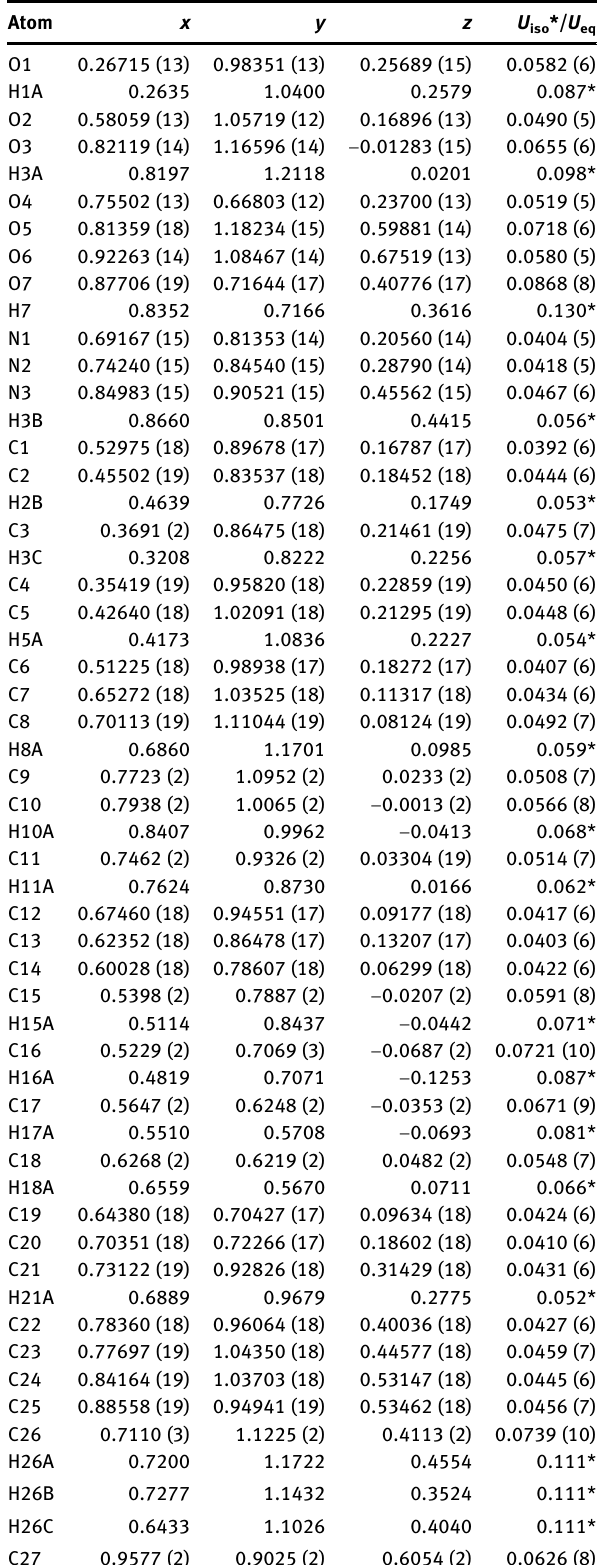
Table  : Fractional atomic coordinates and isotropic or equivalent isotropic displacement parameters (Å 